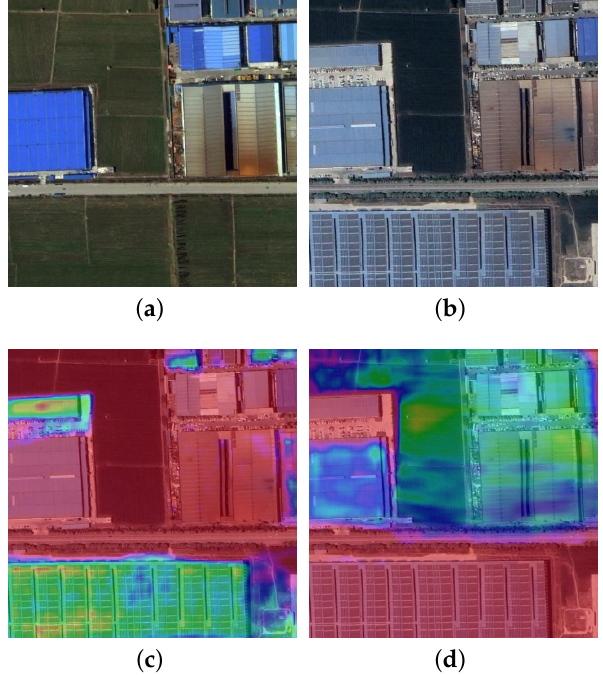
Figure 6. Heat maps of difference module and assimilation module. ( a ) Bitemporal Google Earth image. ( b ) Bitemporal Google Earth image. ( c ) Differential module heat map. ( d ) Assimilation module heat